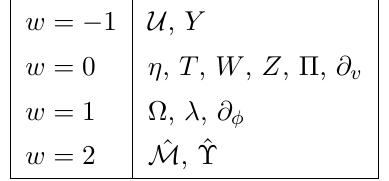
Table 1 . Weight w for various quantities defined and used in this